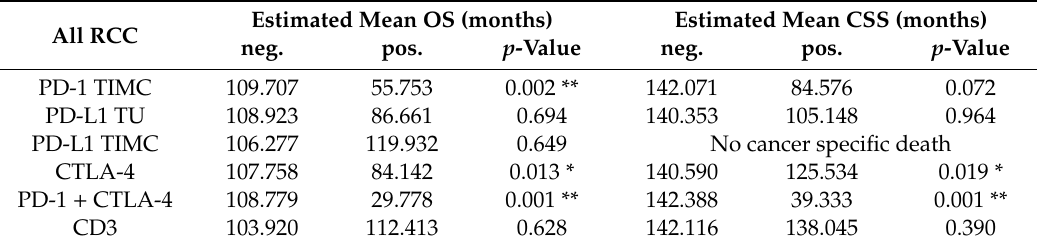
Table 3. Survival analysis (Log rank test) in all renal cell carcinoma (RCC) patients.